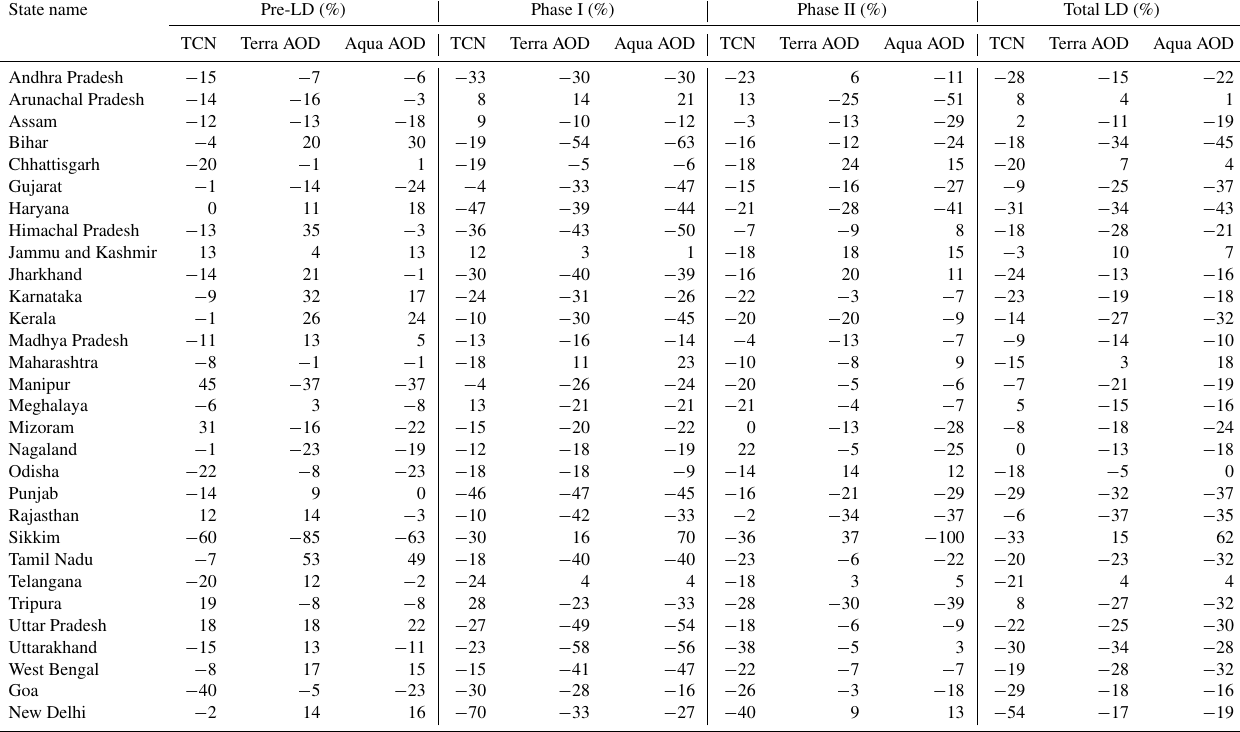
Table 3. State-wise RoC (%) computed during pre-LD, phase I, phase II, and total LD for TCN, Terra MODIS-derived AOD 550 , and Aqua MODIS-derived AOD 550